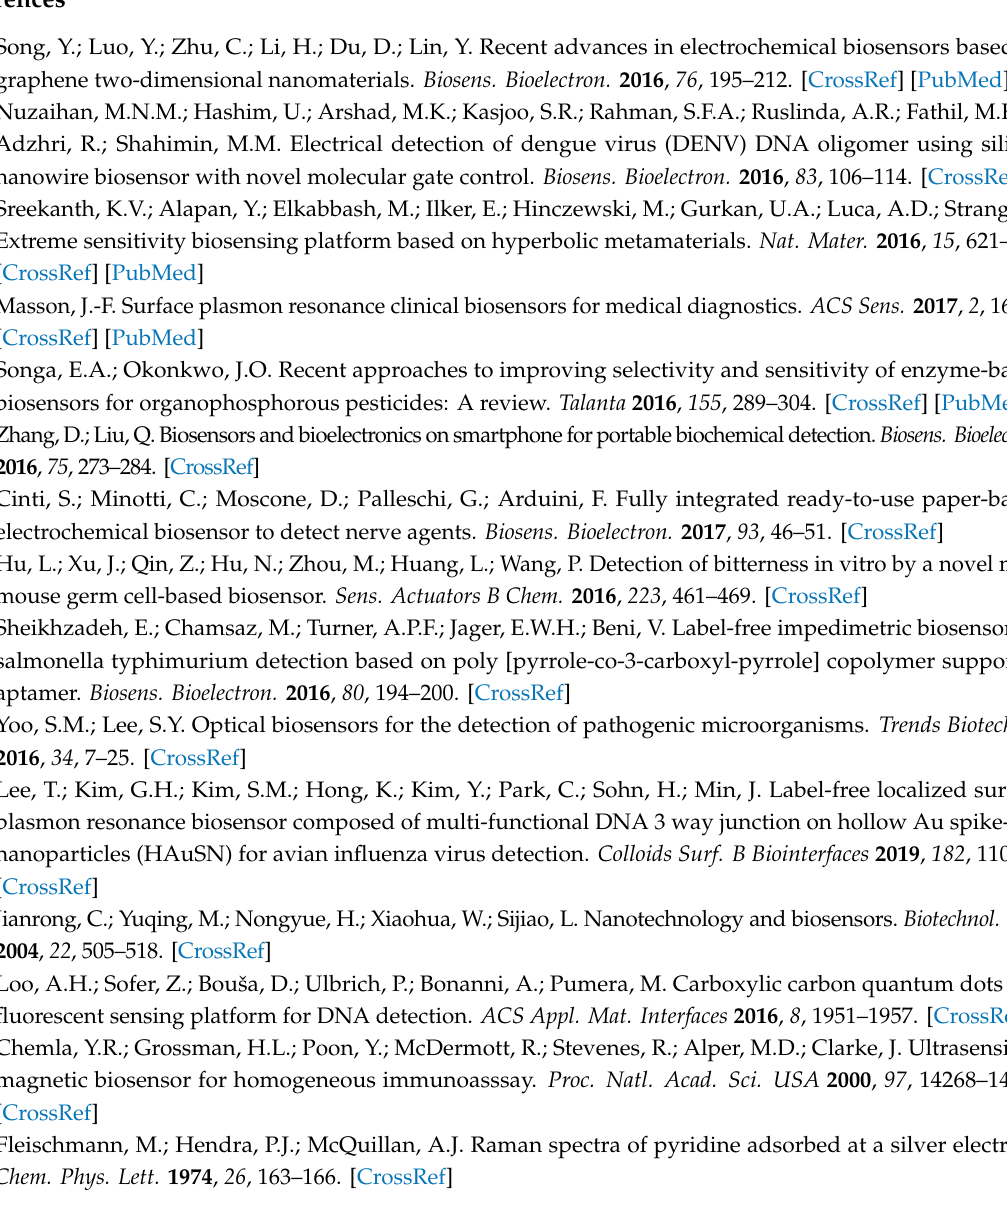
Figure A1. Absorbance of 1× Au–Te.